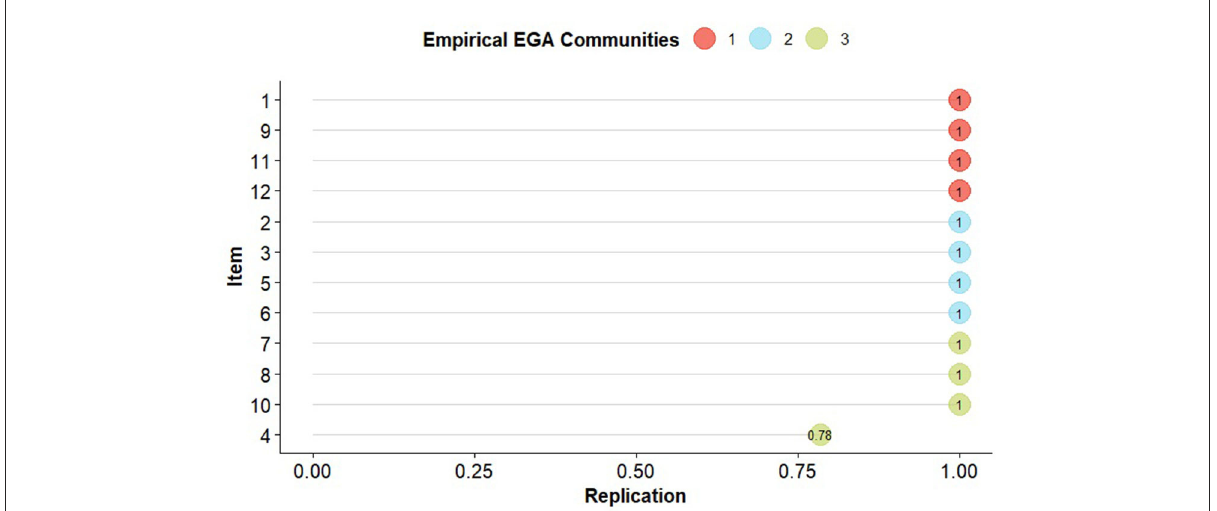
FIGURE3 Empirical communities of the 12 chronic conditions of the EGA. The nodes represent each replication of the item (comorbidity) in the original dimension specified by the EGA. (1) Arthritis, (2) Obesity, (3) Diabetes, (4) Kidney disease, (5) High blood pressure, (6) High blood cholesterol, (7) Heart attack, (8) Coronary heart disease, (9) Asthma, (10) Stroke, (11) Respiratory diseases, (12) Depression.